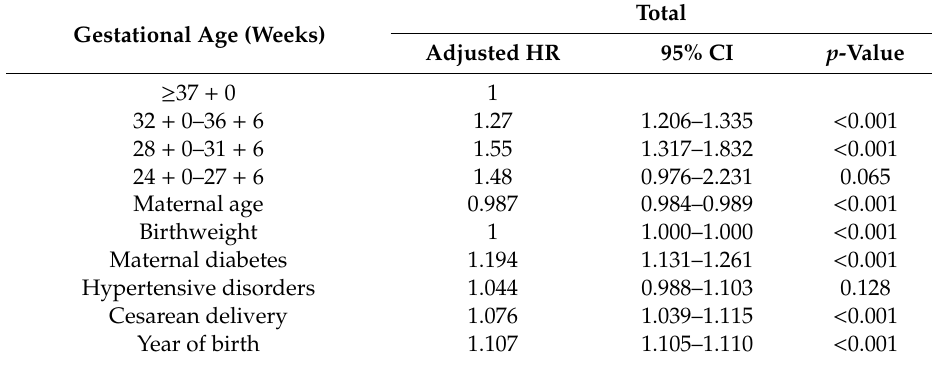
Table 5. Cox regression model for infectious morbidity according to gestational age at